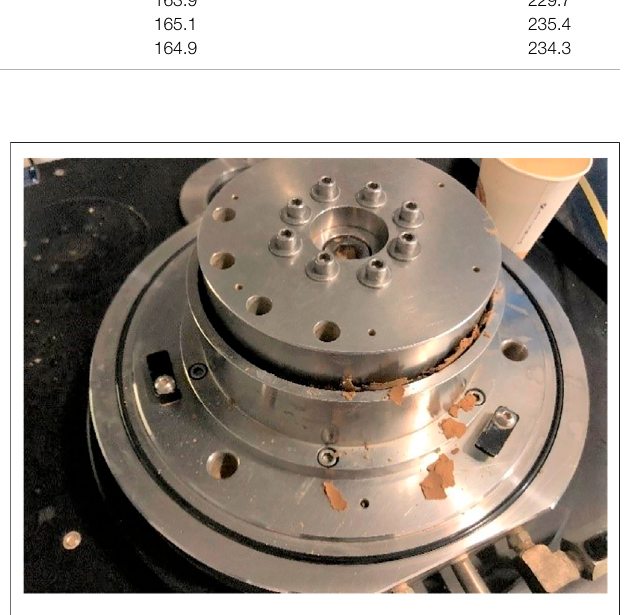
FIGURE 13 | The relationship between shear strength index and moisture content.